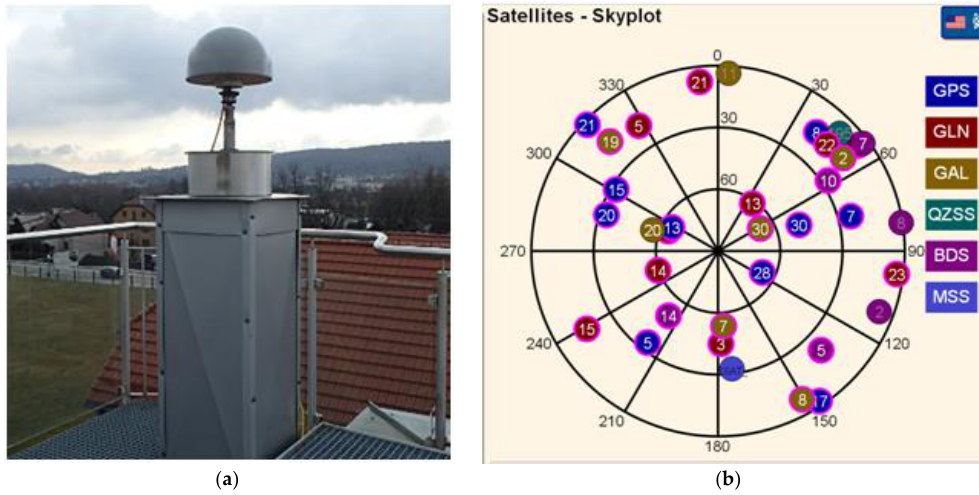
Figure 3. View of: ( a ) Reference station KRUR, ( b ) Skyplot satellites KRUR.